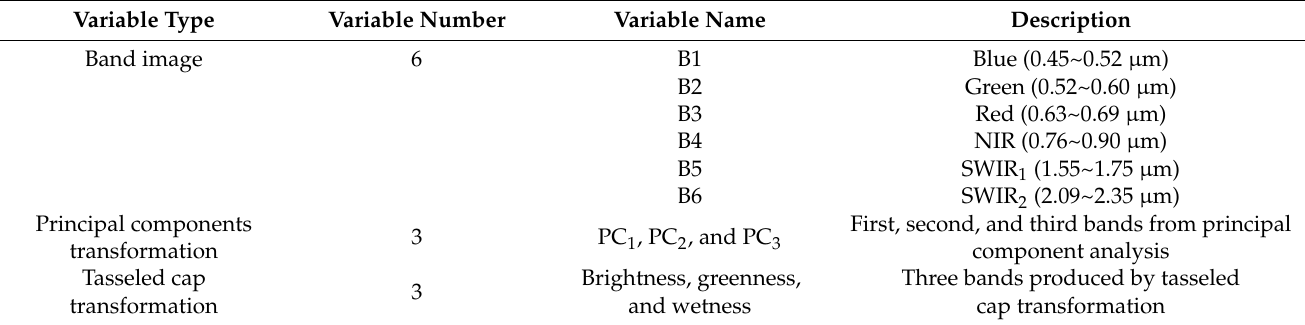
Table 4. Summary of predictors for forest vegetation carbon storage